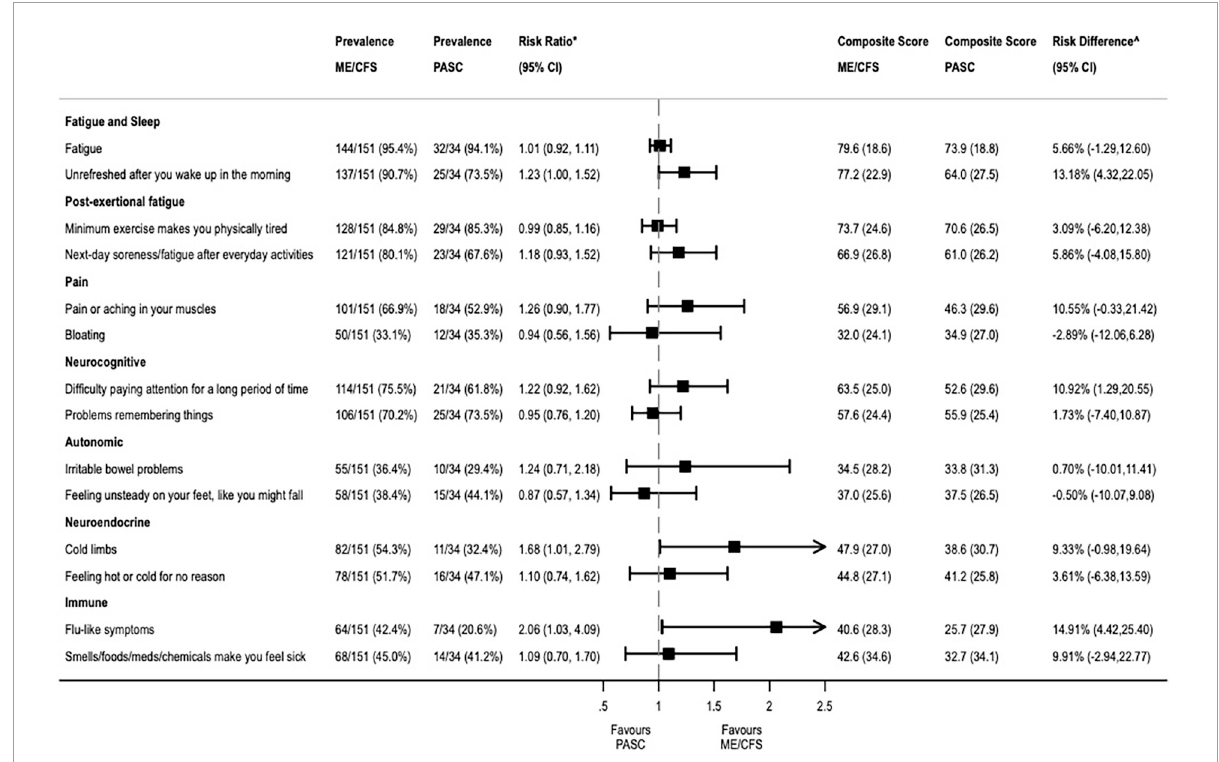
FIGURE1 Differences in mean composite score of baseline symptoms between PASC and ME/CFS.